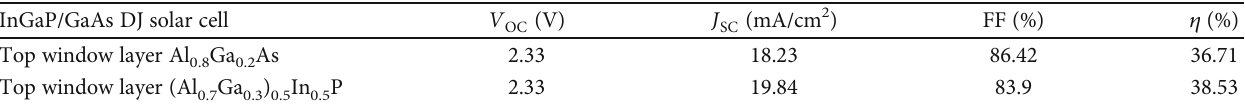
Ga As and 0.8 0.2